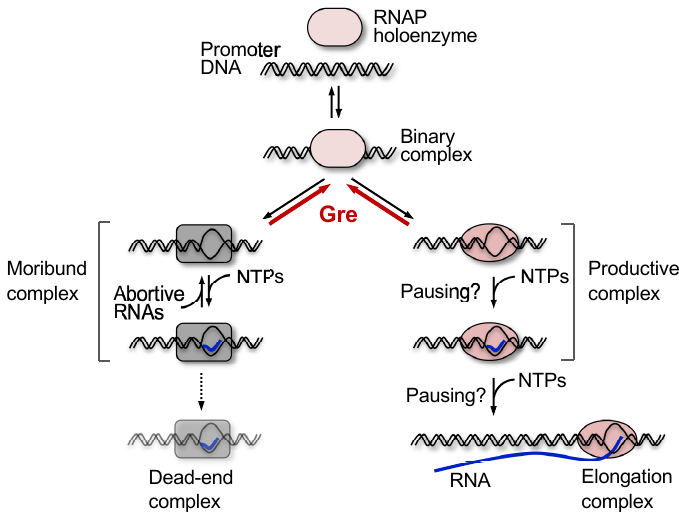
Figure 1. Branched initiation pathway. The action of Gre proteins at branches is shown by red color. In the presence of Gre proteins, the branching becomes reversible (thick red arrows) so that the moribund and the productive complexes can be exchanged each other [15]. Abortive RNA synthesis by the moribund complex is a slow process compared to full-length RNA synthesis (usually, up to 20 min [9,23]), which is reduced by Gre proteins, and thus is genome-widely detectable by RNET-seq with Gre-dependency of the data [25]. At several promoters, the moribund complex is further converted into a dead-end complex that still retains abortive RNA but has no elongation activity [8]. RNAP also pauses during productive initiation [10–12,23], which often involves backtracking of RNAP by one bp and thus can be resolved by Gre. Long-lifetime pausing by the moribund complex is incorporated in the processes of abortive